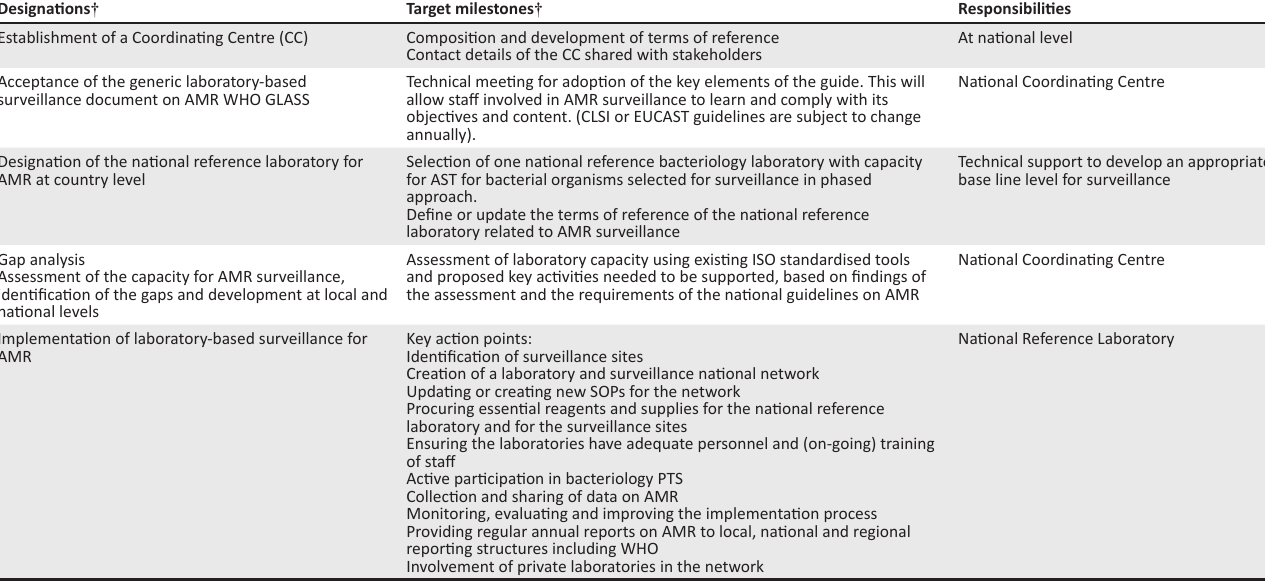
TABLE 3: Design summary for development of laboratory-based surveillance